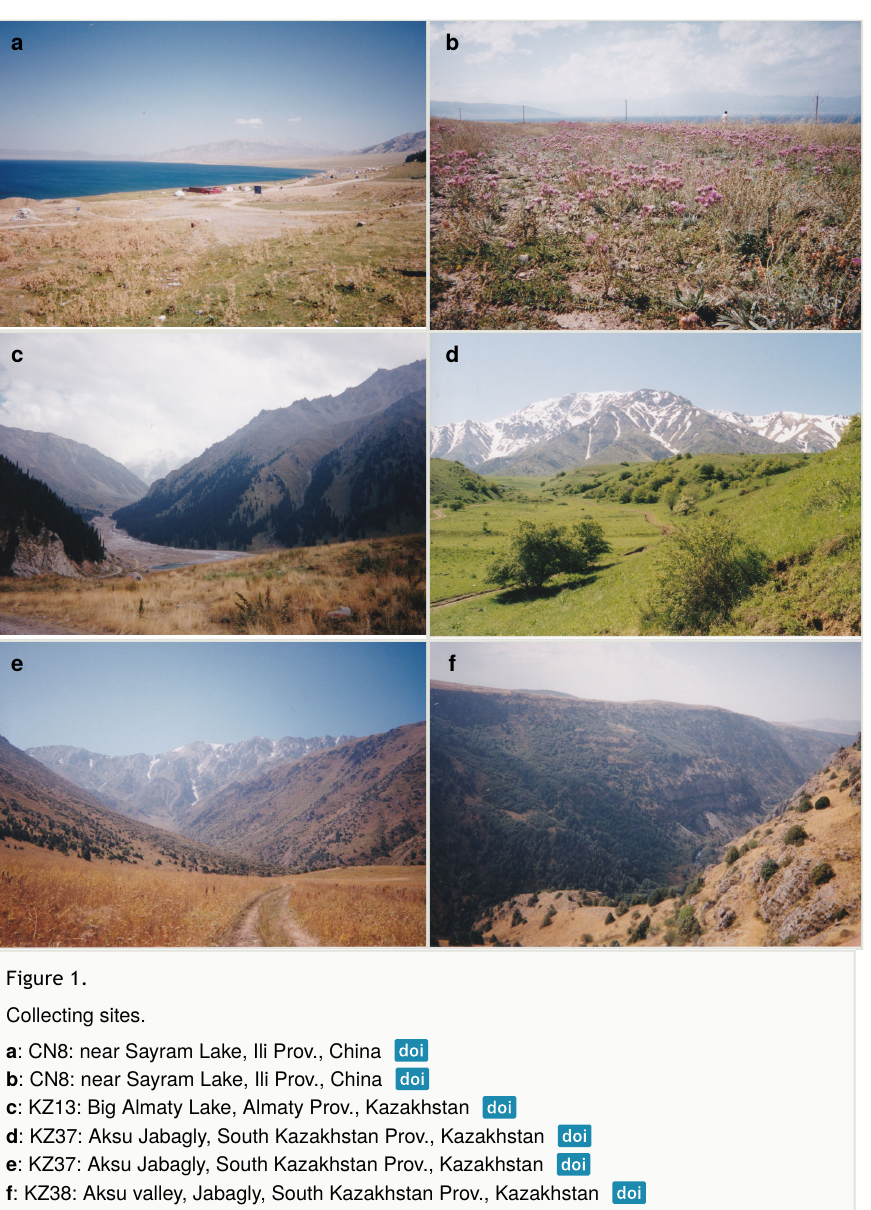
CN8: near Sayram Lake, alt. 1,970 m, Ili Prov., Xinjiang Uyghur Aut. Reg., 25. viii. 2002 (Fig. 1a, b) CN9: Northwest of Kuitun, alt. 450 m, Ili Prov., Xinjiang Uyghur Aut. Reg., 26. viii. 2002 CN10: Qingshuihe, alt. 780 m, Ili Prov., Xinjiang Uyghur Aut. Reg., 25. viii. 2002